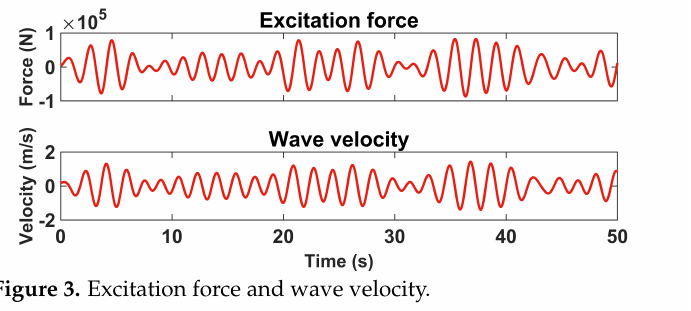
Figure 3. Excitation force and wave